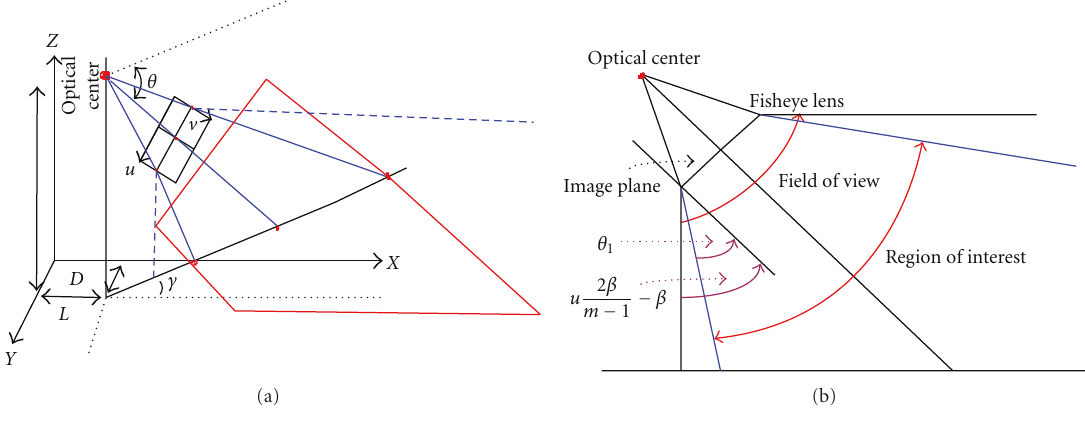
Figure 6: The original and adjusted